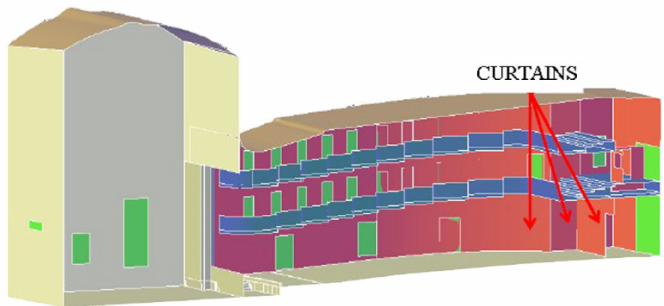
Figure 8. Draped